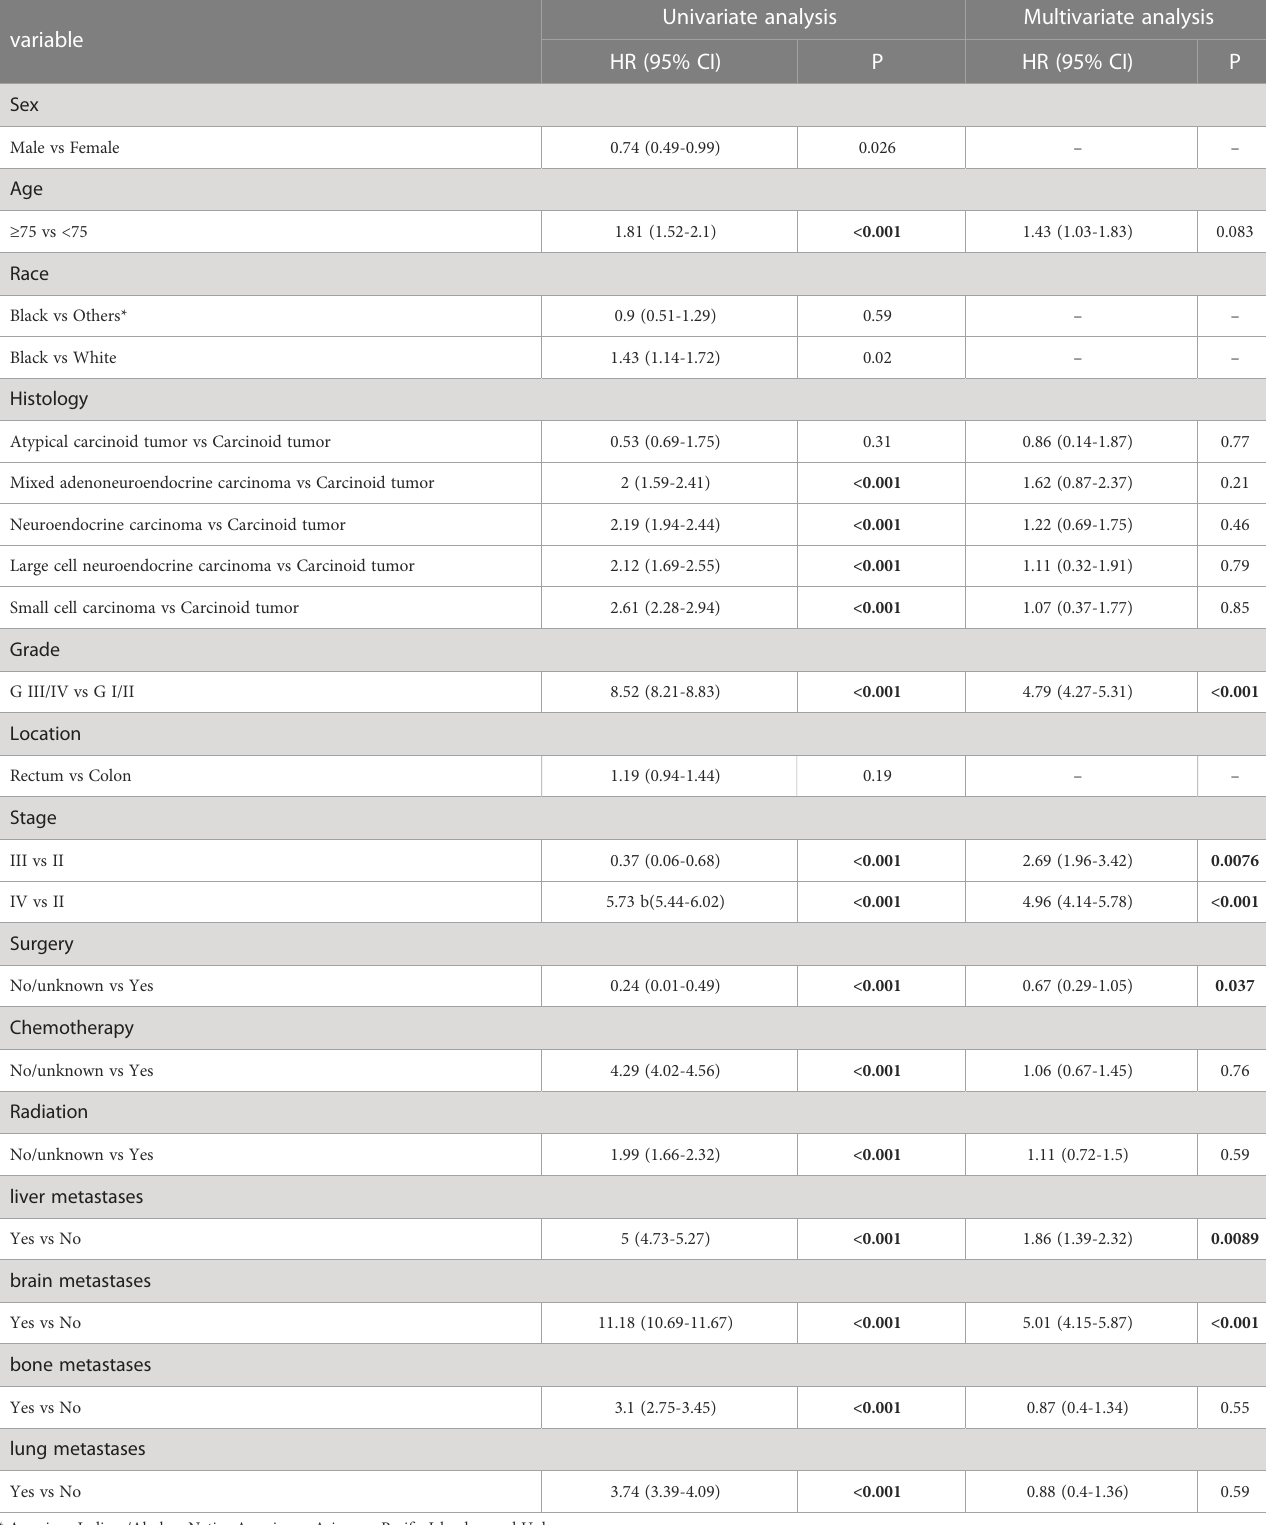
TABLE 3 Univariate and multivariate competing risk analysis of DSS of the II-IV stage patients with CRNENs.